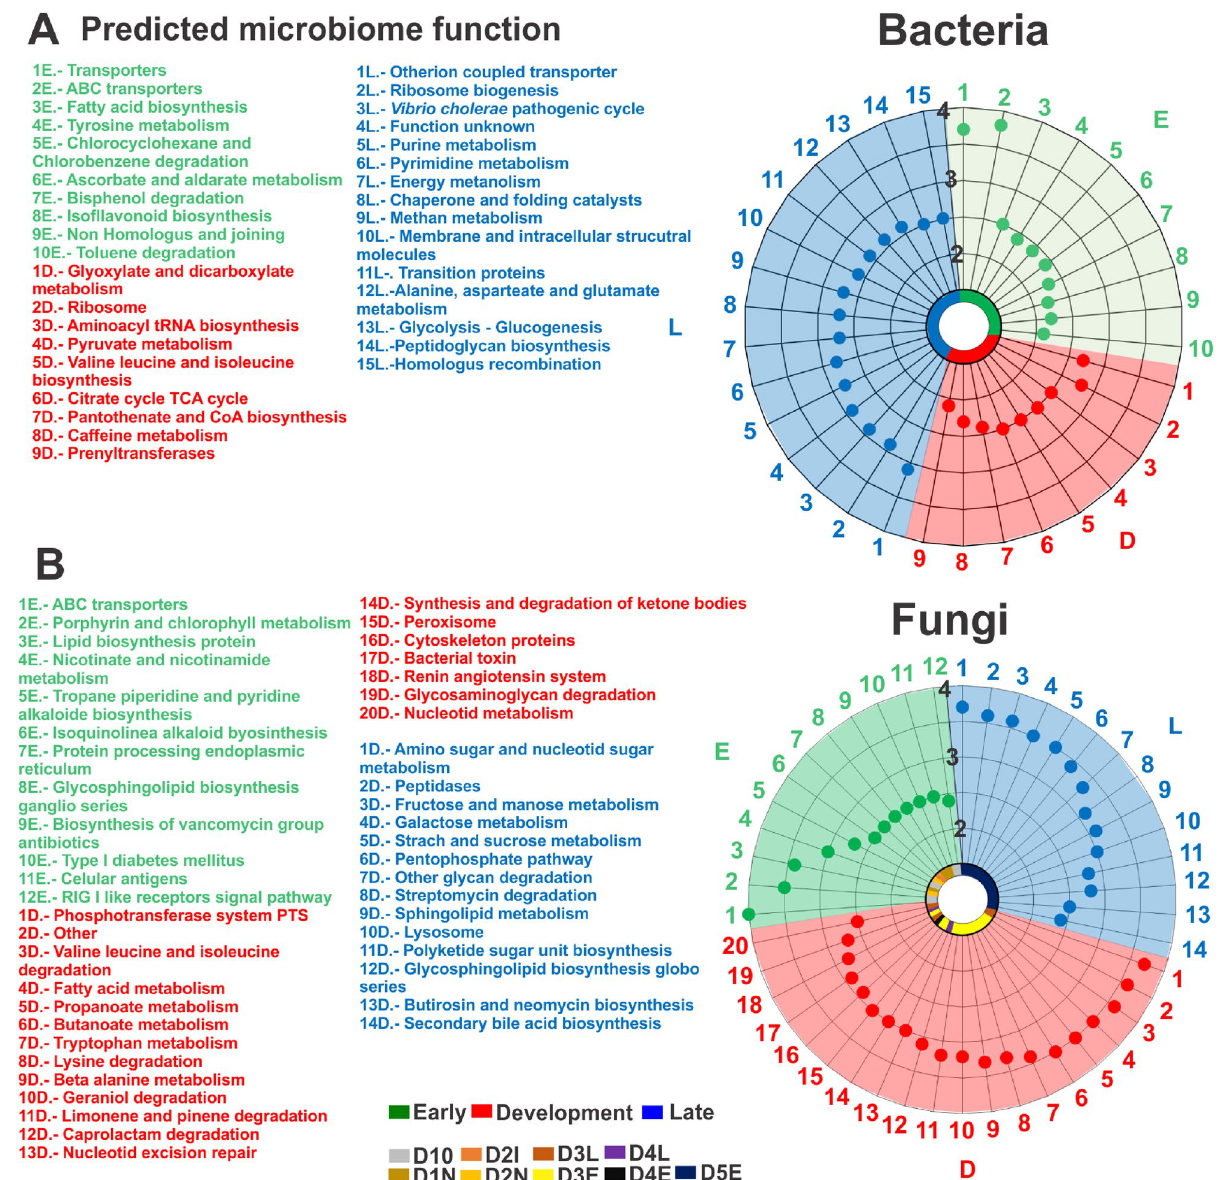
Figure 7. Difference of enriched KEGG metabolic pathways between disease stages groups. The graph shows the predicted microbiome functions according to ( A ) bacteria and ( B ) fungi found at the early (E; green), development (D; red) and late (L; blue) stages of the disease. Circular graphs show log10 LDA score (1–4) of the enriched KEGG metabolic pathways. For fungi, subgroups of disease-stage were used: control, D1N, D2N, D2I for early-stage, D3E, D3L, D4E and D4L for development-stage and D5E and D5L for late-stage. This image was created using EasyMAP 17 and KEGG database 64